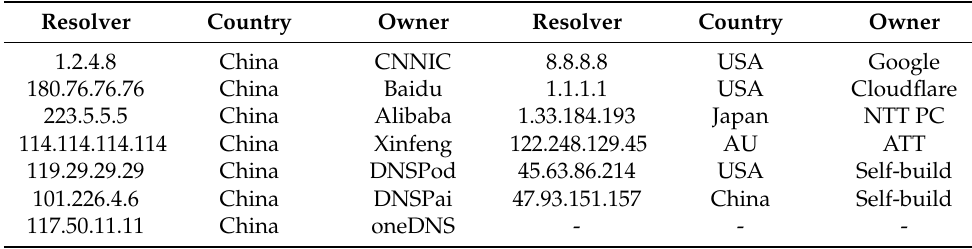
Table 2. The list of public DNS resolvers.